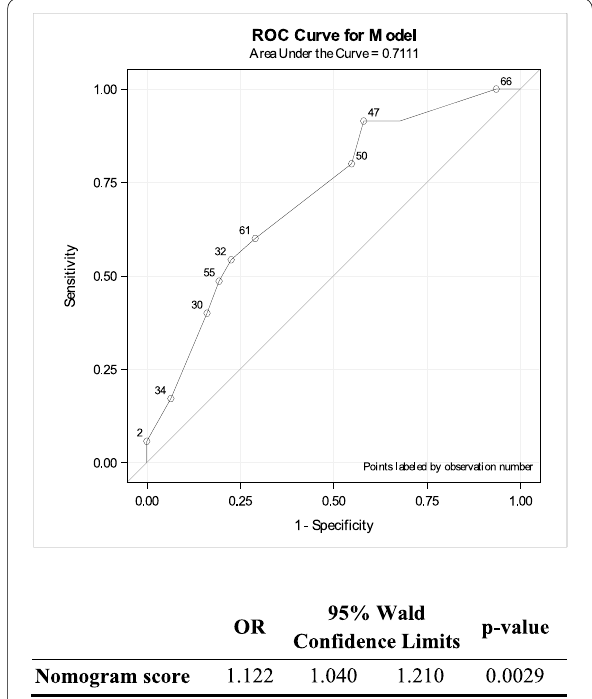
Fig. 2 Receiver operating characteristic (ROC) curve of the multivariate regression model for predicting success of catheter drainage in patients with infected pancreatic necrosis using the Dutch nomogram based on male sex, multiorgan failure, percentage of pancreatic necrosis, and density of the collection [8]. The area under the curve was 0.71 (95% confidence interval, 0.5869;